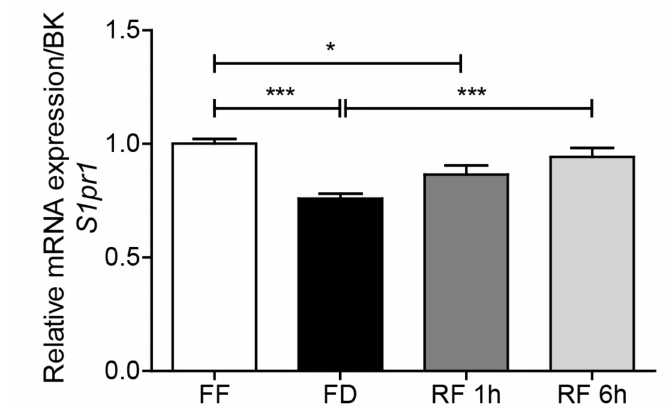
Figure 5. E ff ects of feeding status on transcription of sphingosine-1-phosphate receptor 1 ( S1pr1 ). Free feeding (FF), 12 h food deprivation (FD), 1 h refeeding after FD (RF 1h) and 6 h refeeding after FD (RF 6h). Results are expressed as mean ± SEM ( n = 5–8 / feeding condition). * p < 0.05, ** p < 0.01, *** p < 0.001; one-way ANOVA followed by Tukey’s multiple comparison test. BK: